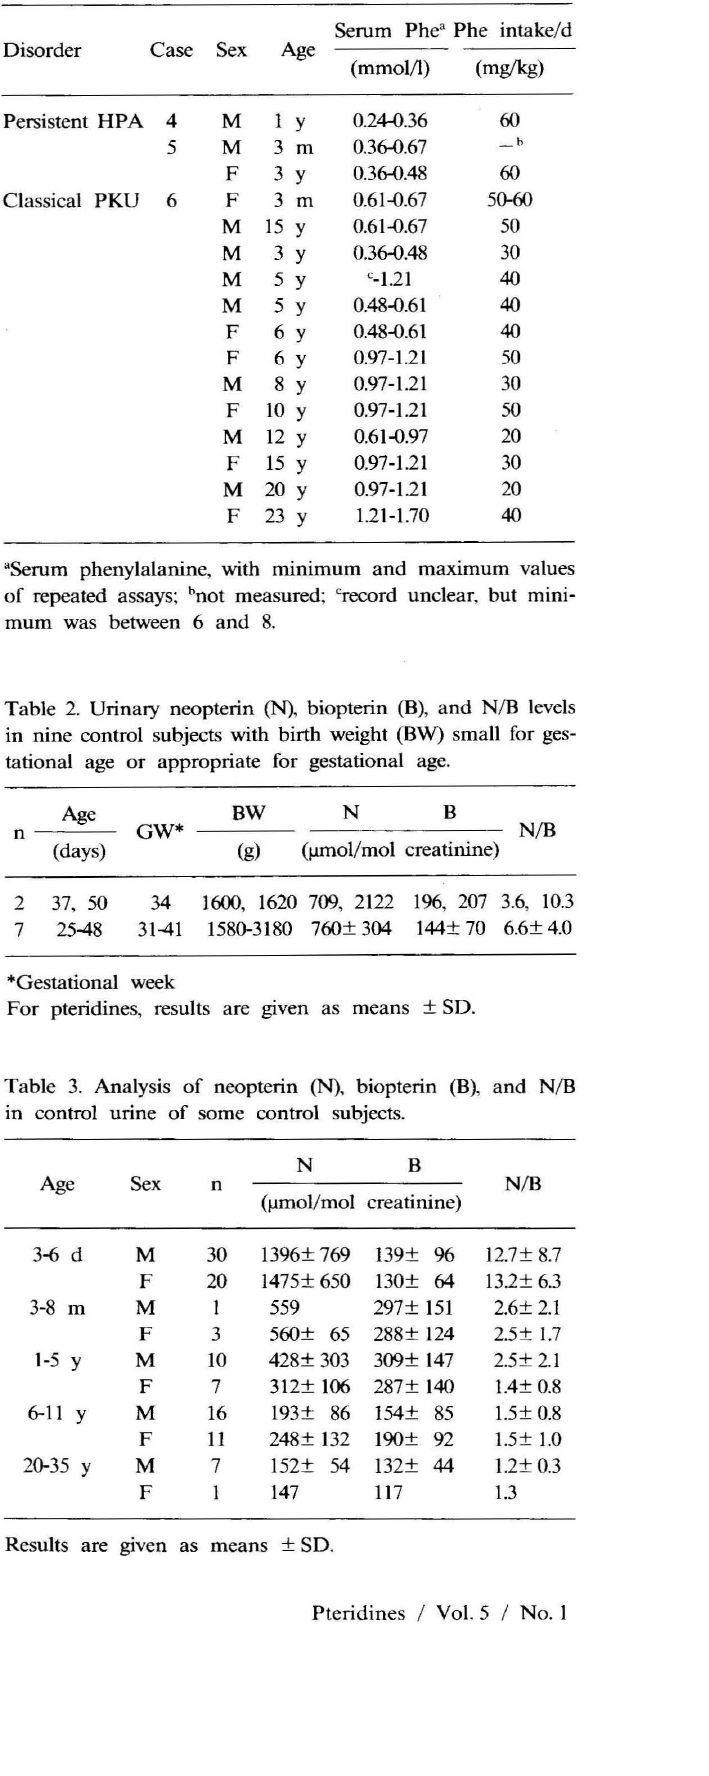
Table 1. Three cases of persistent hyperphenylalaninemia